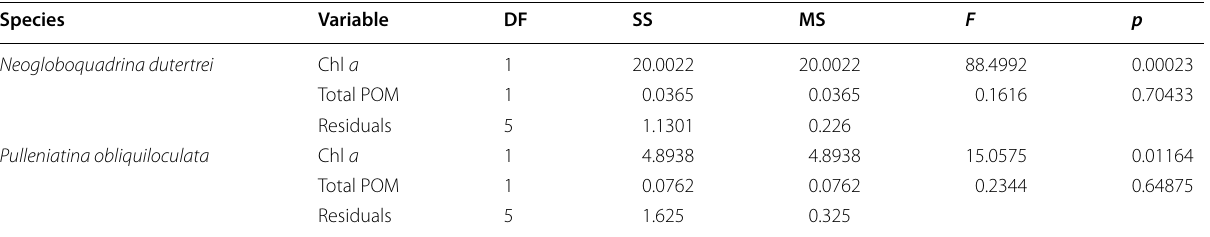
DF, degrees of freedom; SS, Sum of squares; MS, mean squares; F , F ratio; p , probability value